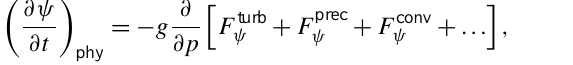
non-linear form with p = 2 on the right side. The results and explicit (long dash) schemes. Function D ( t ) is also shown (full line) for reference.